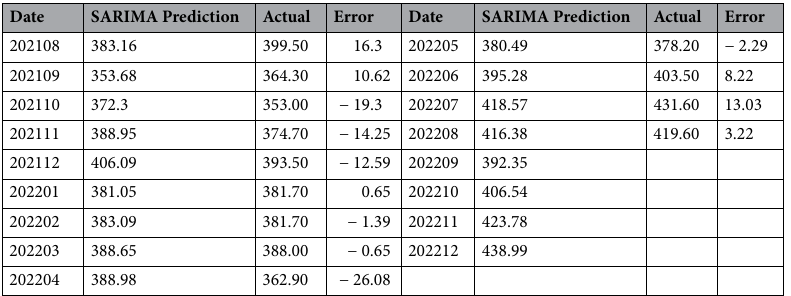
Table 4. The actual values and the predicted values by the SARIMA((1,2,3,4,6,7,11),2,1)(1,0,1)12 model of monthly electric energy production (billion kWh) of Xinjiang. Error = Actual − SARIMA prediction.